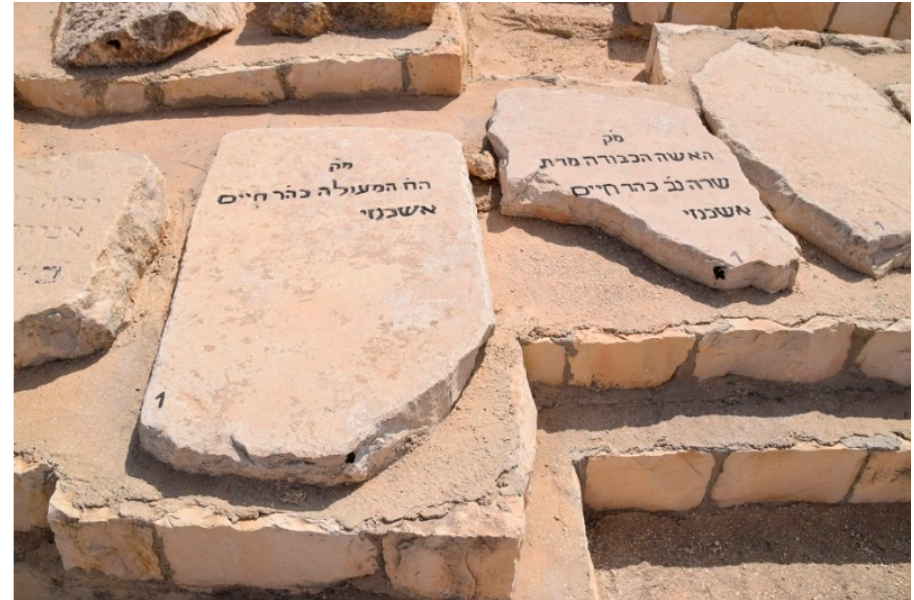
Figure 14. The possible matzevoth of Ḥ ayim and Sarah in the Sephardi cemetery on the Mount of Olives. Photo: Jon Seligman, Israel Antiquities